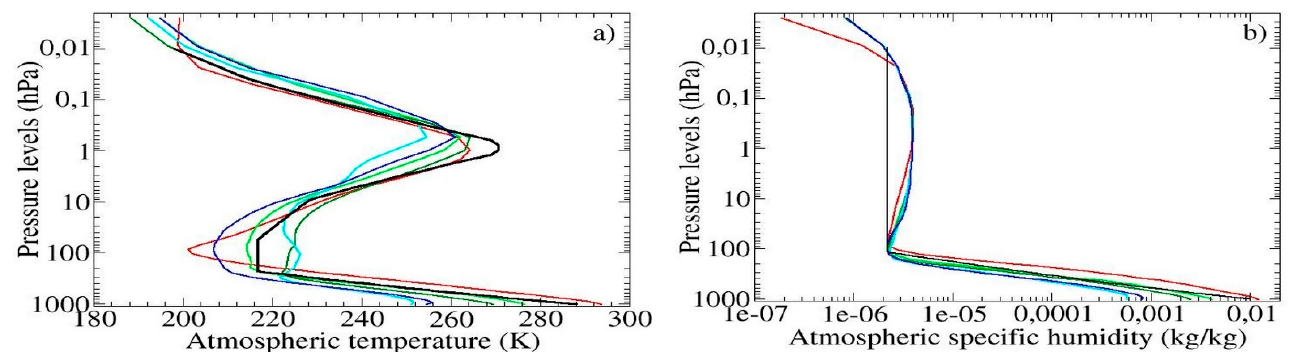
Figure 4. ( a ) Temperature profiles and ( b ) humidity profiles for standard atmosphere (in black) and for five typical TIGR atmospheres (tropical in red, mid-latitude in green and dark green, polar in cyan and blue).